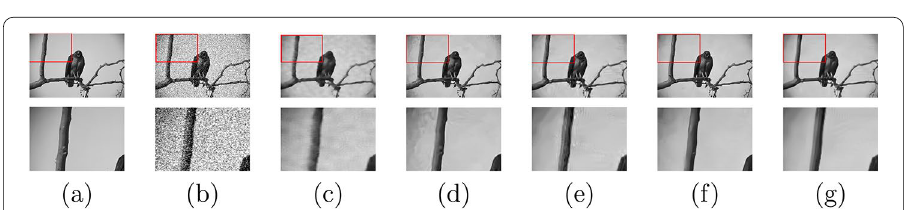
Fig. 8 Denoising results of natural image ( bird ) with the noise variance σ = 50 [top] and zoom-in image [bottom]. From the left ( a ) to right ( g ) are: the orig inal image, the noisy image, the results obtained by NLM, BM3D, OGLR, ADnet and the proposed method respectively